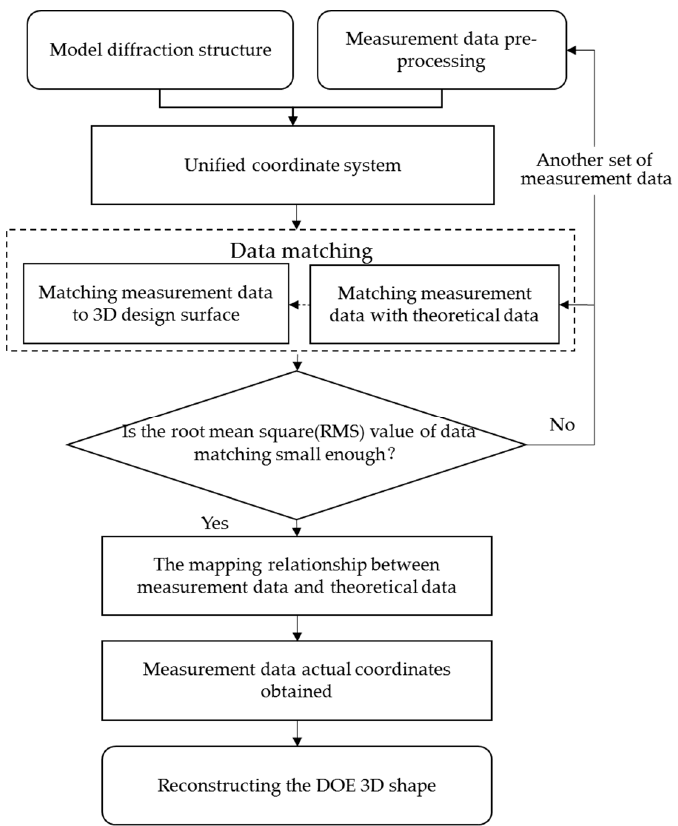
Figure 2. Flowchart for processing chromatic confocal probe measured data by the proposed algorithm.